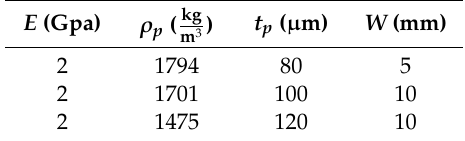
Figure 1. ( a ) Water tunnel experiments apparatus. ( b ) Flexible plate clamped to the square cylinder. Table 2. Plate properties for the water tunnel experiments.